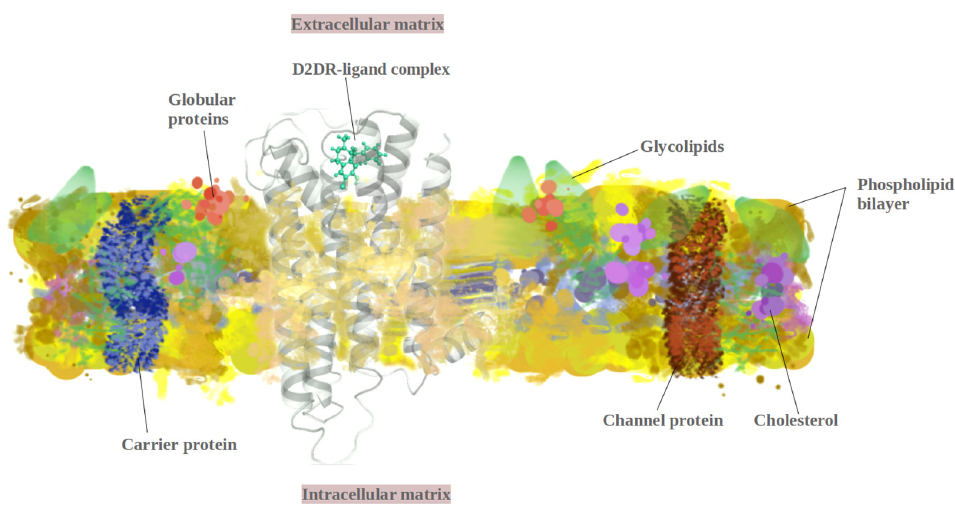
Figure 2. D2DR membrane protein structure.